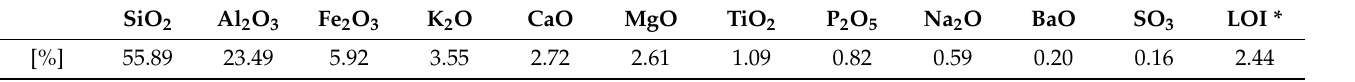
Table 3. Oxide composition of fly ash (Skawina, Poland).